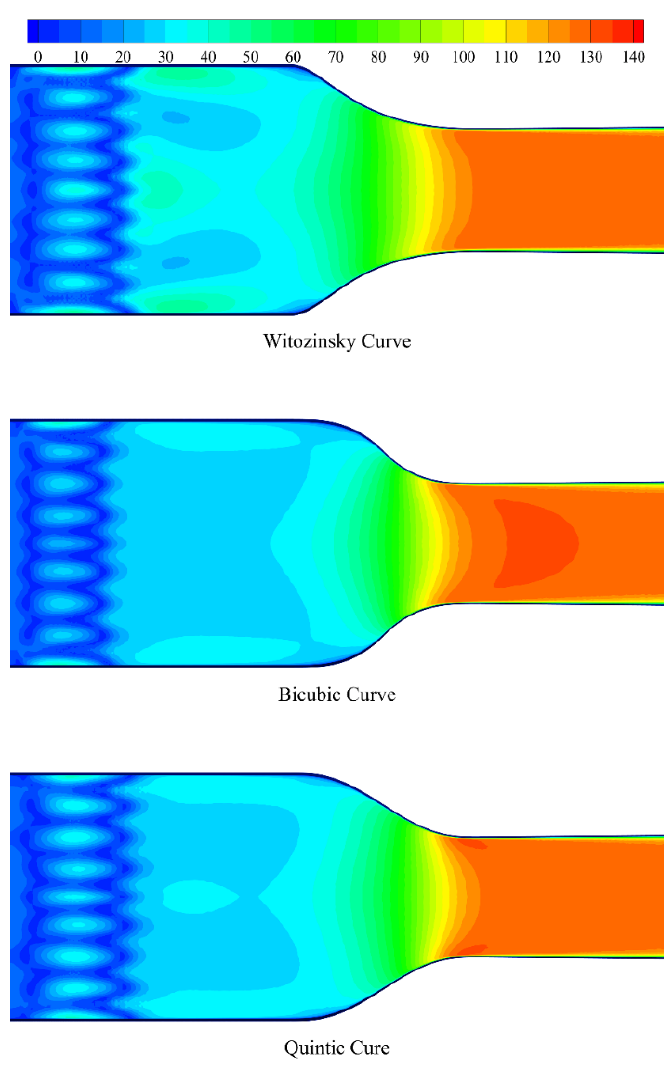
Figure 11. Velocity distributions of three different wind tunnels (m/s). To quantify the flow uniformities and flow stabilities of the test sections of the three different wind tunnels, we select nine points in a test section and measure some key parameters. The nine measuring points, named ‘A~H’ and ‘O’, are shown in Figure 12. The test section (0.6 m long) is divided into three cross sections: x = 0.1 m, x = 0.3 m, and x = 0.5